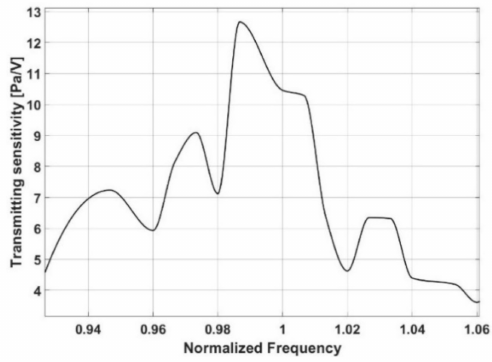
Figure 6. Transmit sensitivity of the proposed plane array.